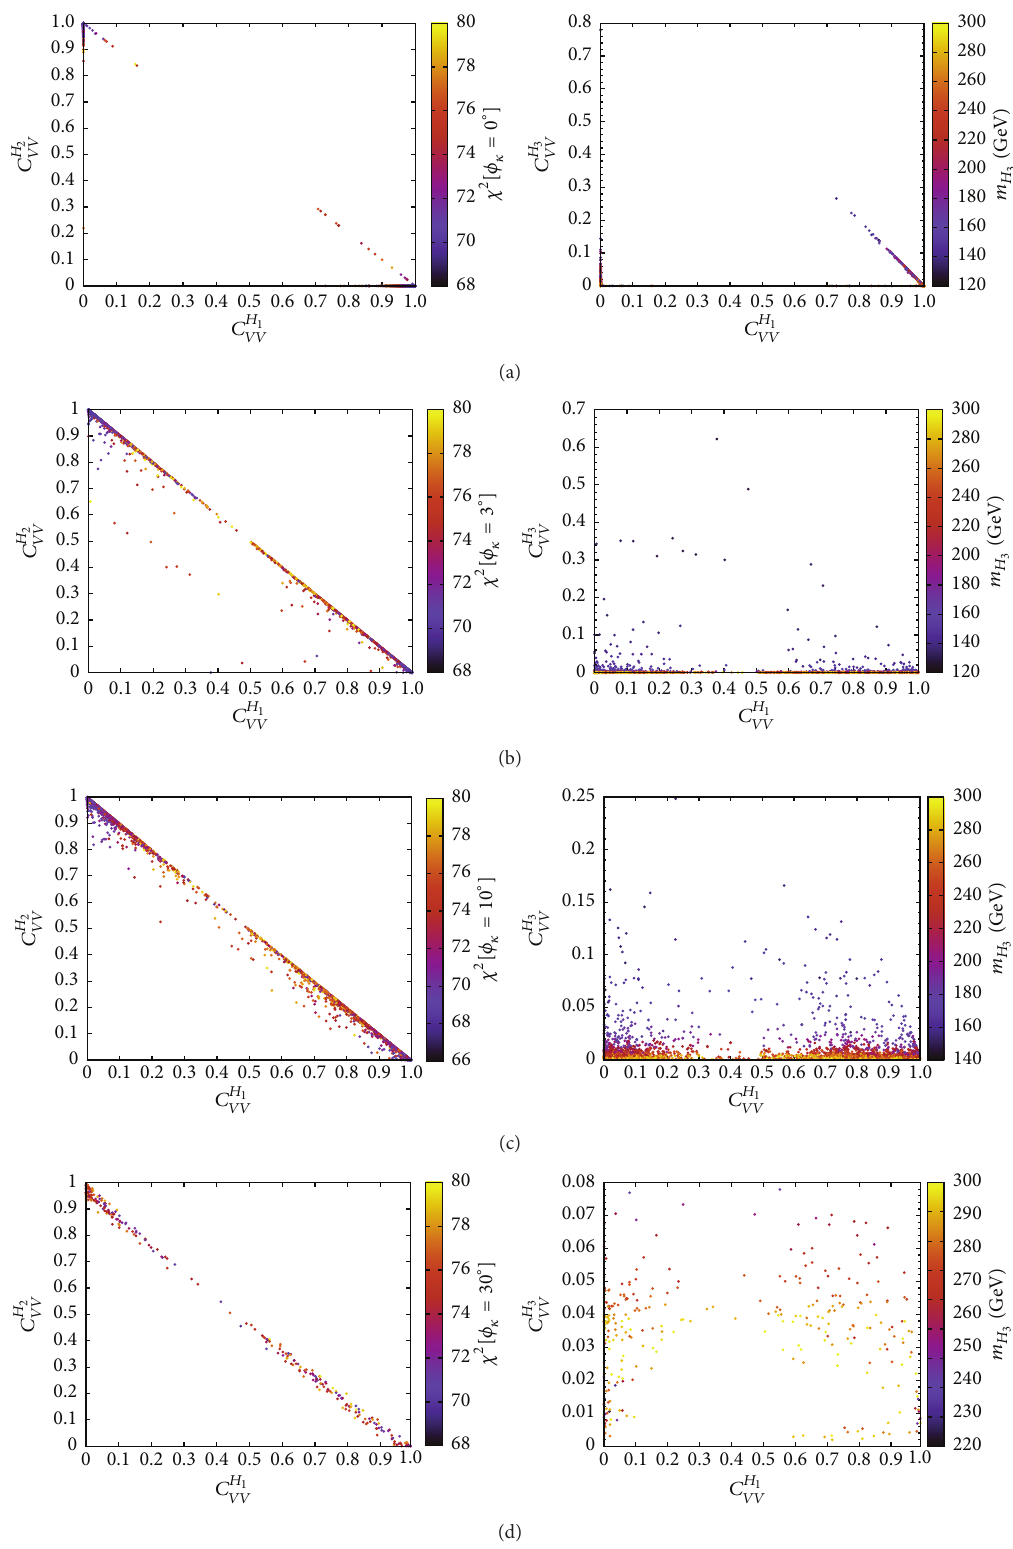
Figure3:Squarednormalisedcouplingof 𝐻 1 tothegaugebosonsversusthatof 𝐻 2 (left)andof 𝐻 3 (right)inthescenariowhen 𝐻 obs = 𝐻 1 +𝐻 2 , with 𝜙 𝜅 set to (a) 0 ∘ , (b) 3 ∘ , (c) 10 ∘ , and (d) 30 ∘ . The heat map in the left panels shows the distribution of 𝜒 2 and in the right panels that of 𝑚 𝐻